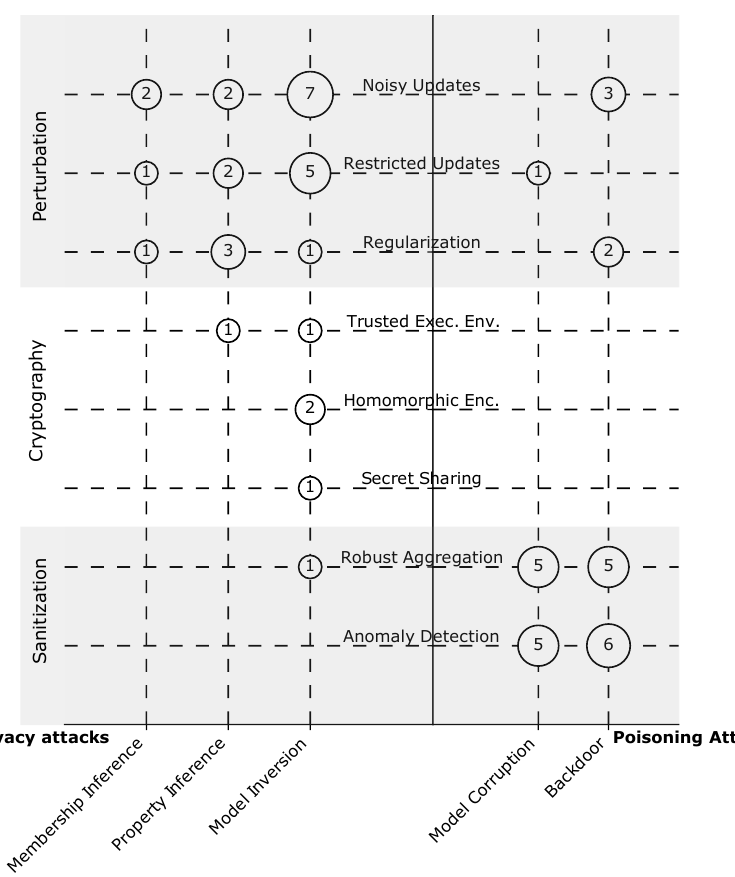
Figure 12. Bubble chart that shows the papers’ distribution in two dimensions: attack purpose and countermeasures. We see that perturbation and cryptography-based countermeasures are mainly used for privacy attacks, and sanitization is used for poisoning